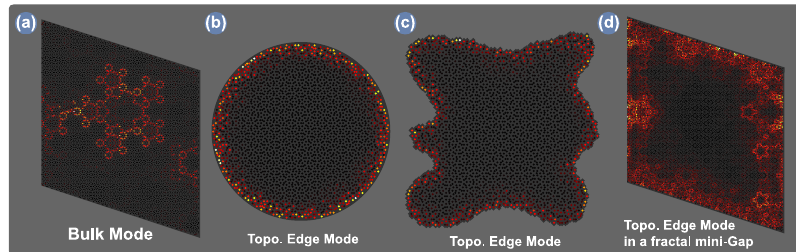
Figure 3: Two-dimensional photonic topological insulator quasicrystals